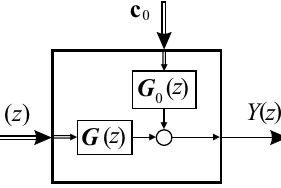
Figure 4. Equivalent full block diagram of the closed loop